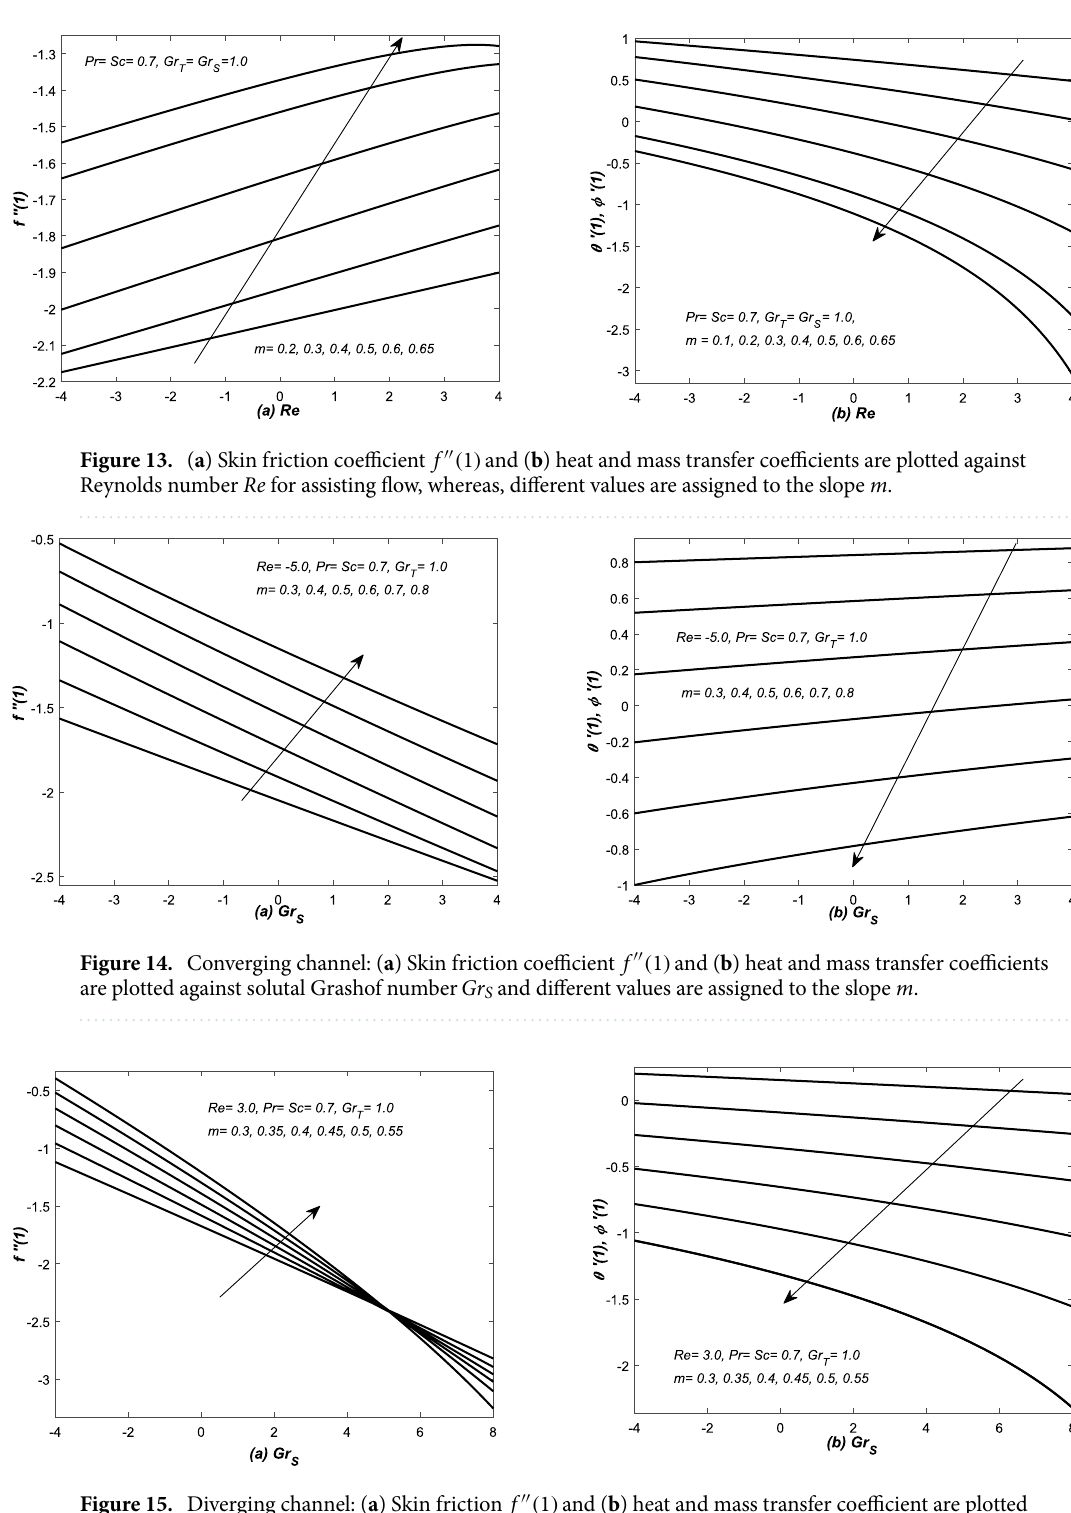
Figure 15. Diverging channel: ( a ) Skin friction f ′′ ( 1 ) and ( b ) heat and mass transfer coefficient are plotted against solutal Grashof number Gr S and different values are assigned to the slope m